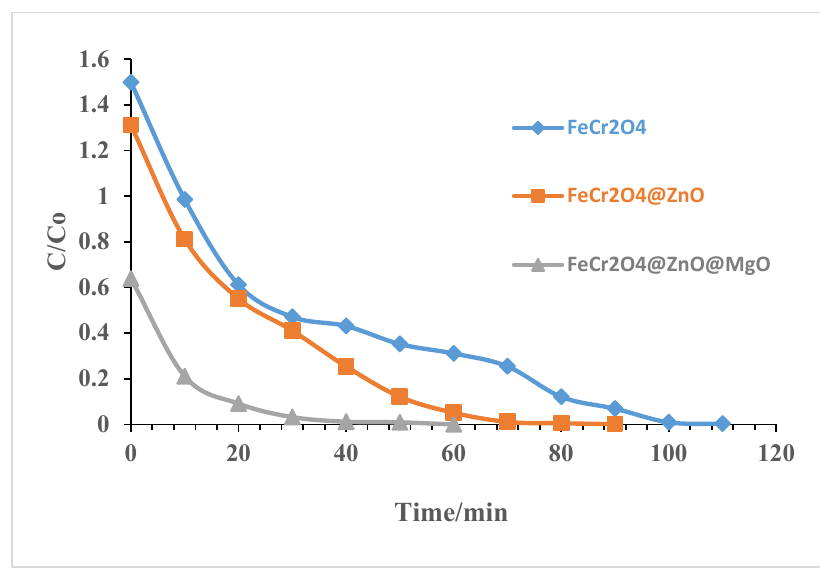
Fig. 11. Compare Photocatalytic Efficiency of Synthesised nanoparticles.